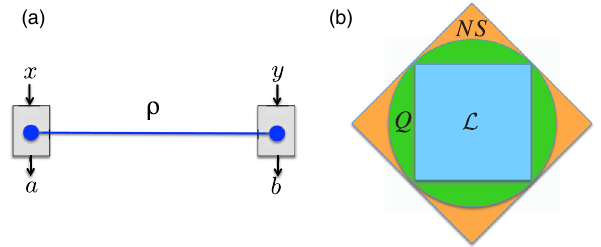
FIG. 1. (a) Bell test scenario. Alice and Bob perform “ black box ” measurements on a shared (quantum) state ρ . The experi- ment is characterized by the data f p ð a; b j x; y Þg , i.e., a set of conditional probabilities for each pair of measurement outputs ( a and b ) given measurement settings x and y . Based on the data p ð a; b j x; y Þ , Bell inequalities [see Eq. (3)] can be tested. (b) Geometrical representation of nonsignaling correlations. The set of local ( L ), quantum ( Q ), and nonsignaling ( N S ) distributions are projected onto a plane, where the following inclusion relations are clear: L ⊂ Q ⊂ N S